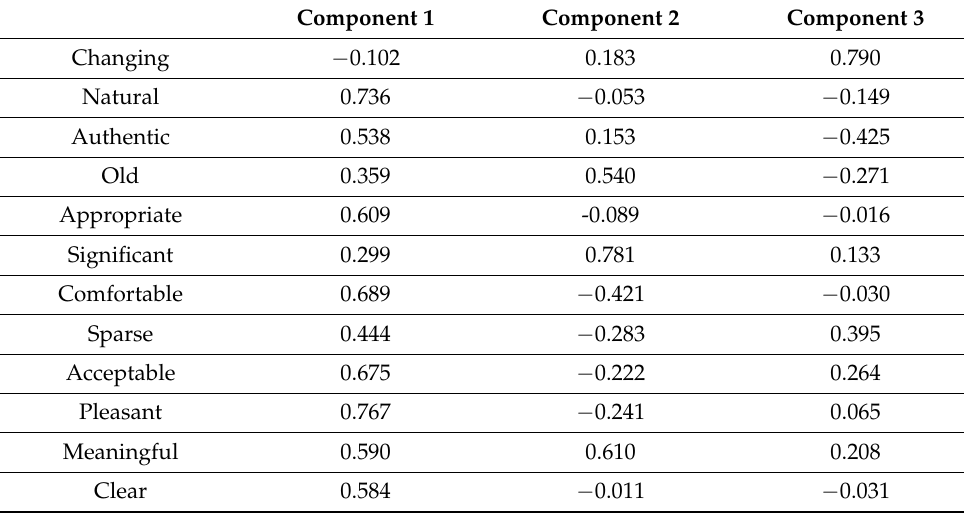
Table 2. Principal components related loadings of the semantic